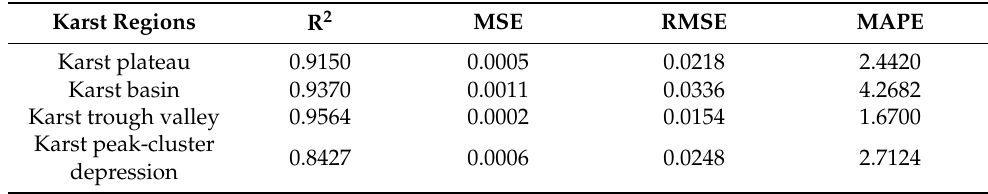
Table 4. The prediction accuracy of the SVR